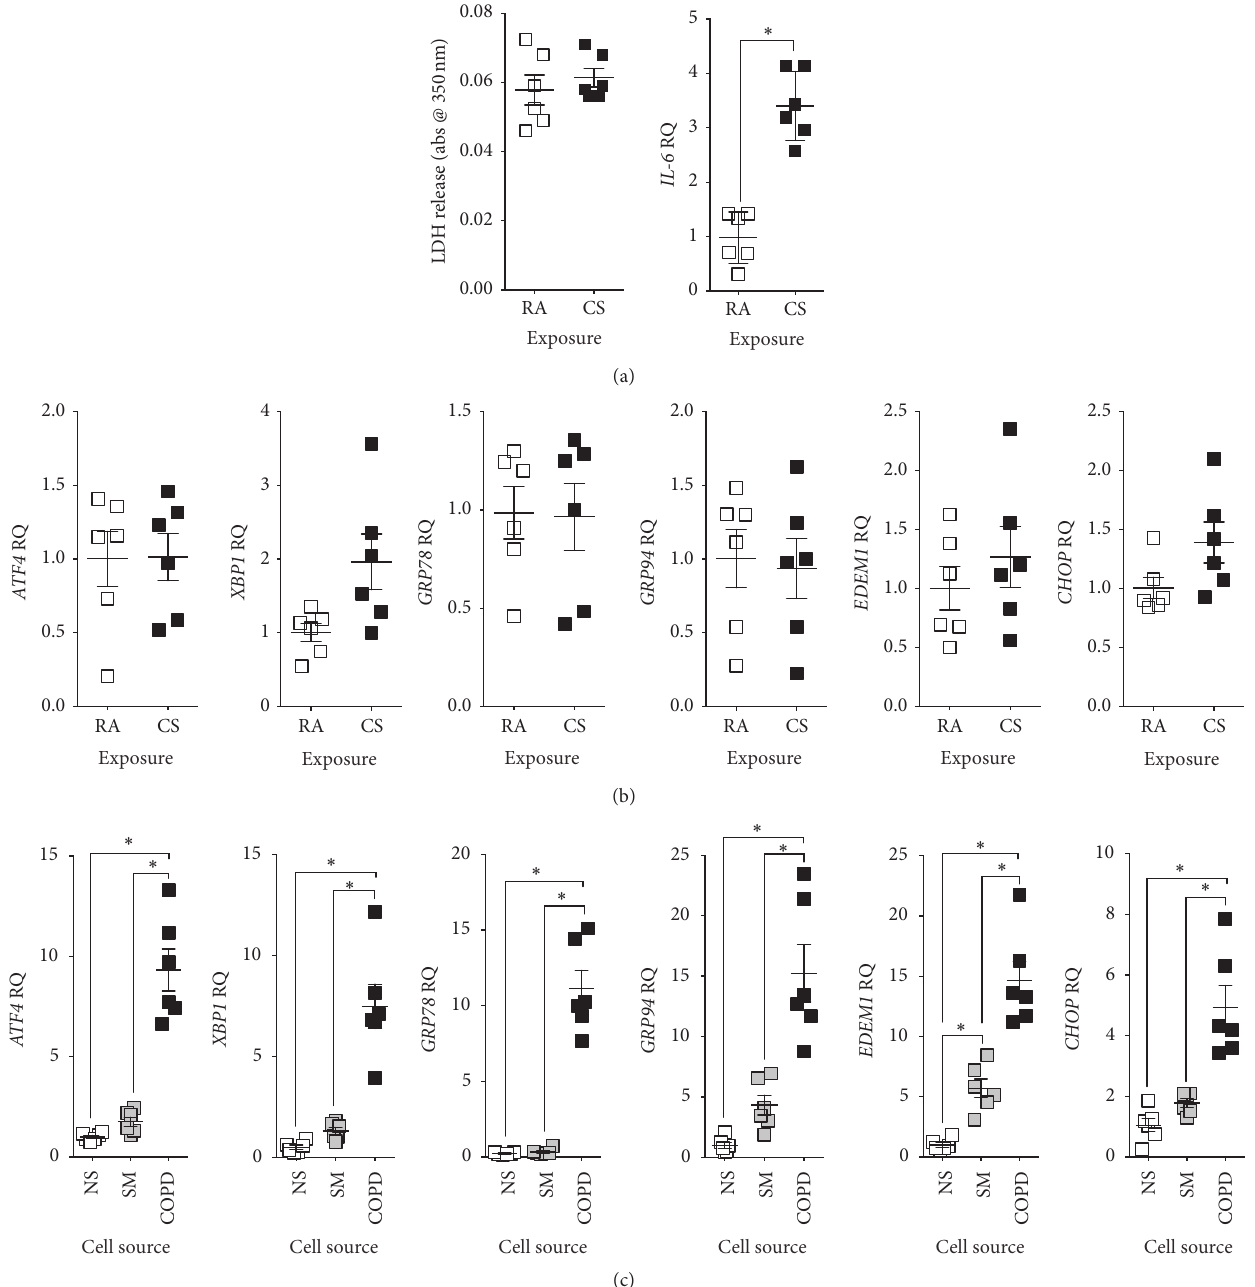
Figure 1: NHBE cells isolated from COPD donors have enhanced ER stress responses compared to nonsmokers and smokers. (a) Fully differentiated NHBE cells from nonsmoking individuals ( 𝑛 = 6 ) exposed to room air (RA) or cigarette smoke (CS) from 4 cigarettes every second day (3 exposures) using a Vitrocell VC-10 smoking robot. LDH release into media and IL-6 gene expression were examined. (b) Gene expression of ATF4 , XBP1 , GRP78 , GRP94 , EDEM1, and CHOP was examined. (c) Fully differentiated NHBE cells from nonsmoker (NS), smoker (SM), and COPD (COPD) individuals ( 𝑛 = 6 donors per group) were examined for gene expression of ATF4 , XBP1 , GRP78 , GRP94 , EDEM1, and CHOP . Dot plots are represented as relative quantification (RQ) compared to ACTB expression and shown as the mean ± SEM, where each measurement was performed on 3 independent days on 6 donors/group. ∗ denotes 𝑝 value < 0.05, when comparing both treatments connected by a line, determined by Student’s 𝑡 -test (2 groups) or 2-way ANOVA with Tukey’s post hoc test ( > 2